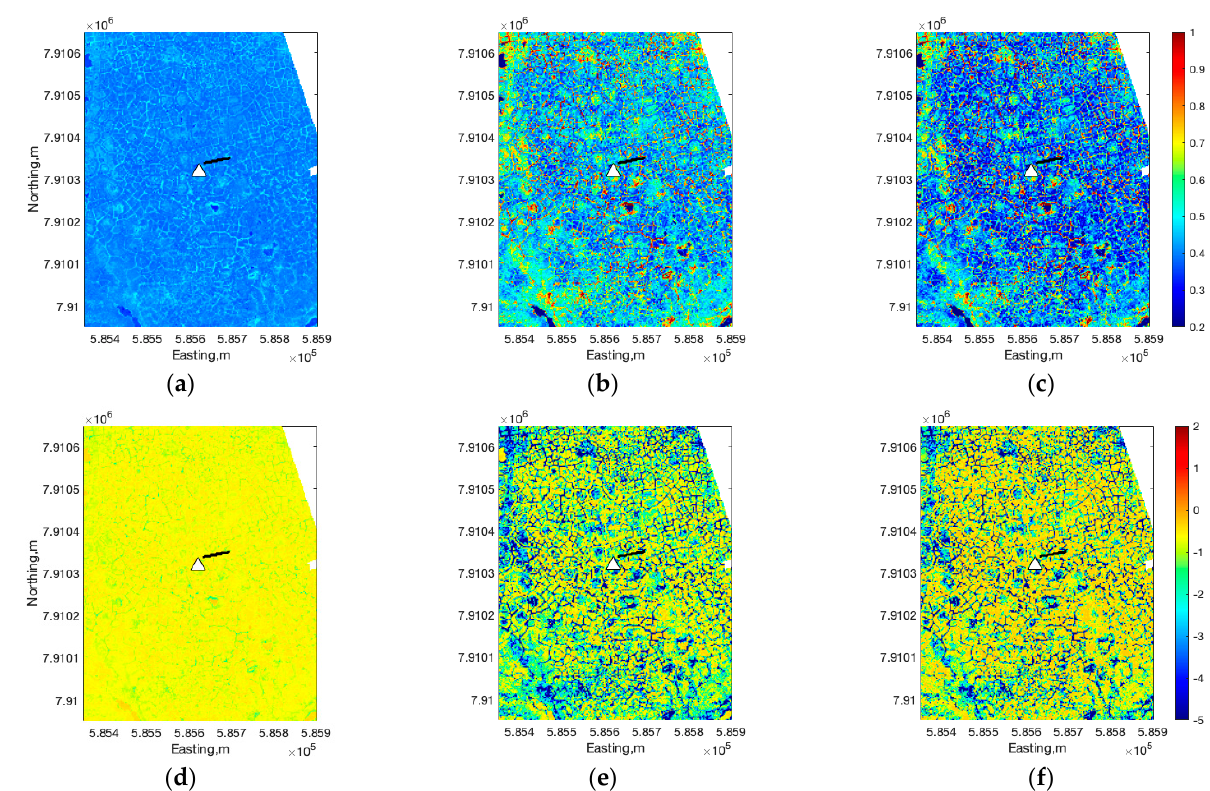
Figure 7. Changes of NDVI over the site in 2014 on ( a ) DOY 185, ( b ) DOY 210 and ( c ) DOY 240, and the changes of NEEday (in μ mol/m 2 /s) over the site on ( d ) DOY 185, ( e ) DOY 210 and ( f ) DOY 240. In each plot, the black line represents the tram location, and the white triangle is the flux tower location.